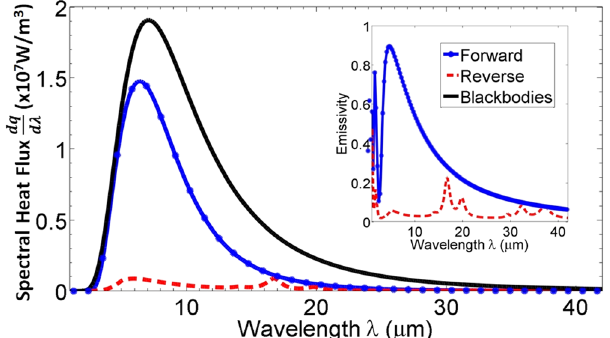
Figure 2. Spectral heat flux across the optimized thermal diode in forward and reverse bias scenarios. Spectral heat flux between blackbodies at temperatures 331 K and 351 K is shown for reference. Inset shows hemispherical emissivity of the active component of the diode for the forward and reverse bias.